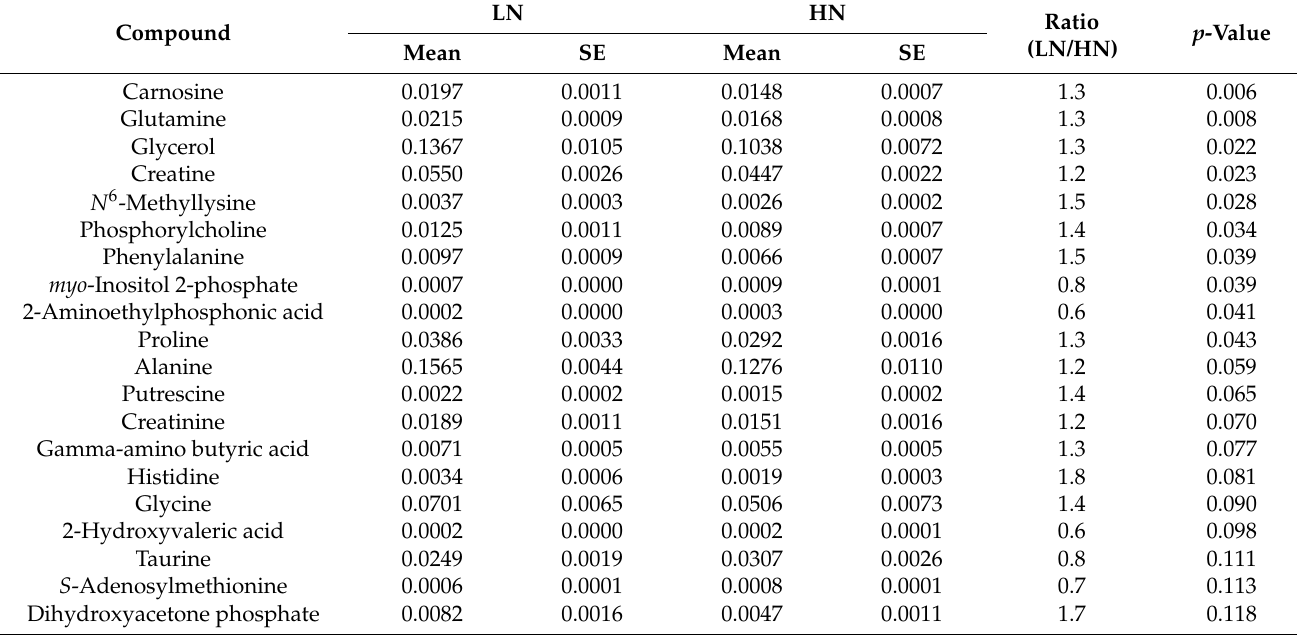
* Values in table are relative content levels (arbitrary unit). LN and HN: Low and high nutrition treatment, respectively. Unsupervised hierarchical clustering analysis (HCA) using the top 50 significantly different metabolites between the LN and HN groups classified the fetal muscle samples into LN and HN groups. Figure 1 shows that glutamine, glycerol, phosphorylcholine, carnosine, N 6 -methyllysine, creatinine, putrescine, creatine, valine, and allantoin were abundant in the LN group, whereas 2-AEP, Ins2P, taurine, S -adenosylmethionine (SAM), acid, 2-HVA, guanosine, and NAD+ were abundant in the HN group, compared with the counterpart group. This result indicated the important contribution of these metabolites to the separation of the fetal muscles between the LN and HN groups. Thus, the fetal muscle of the LN group was characterized by the abundance of metabolites such as carnosine, glutamine, glycerol, creatine, N 6 -methyllysine, phenylalanine, and phosphorylcholine. To understand biological processes associated with differentially expressed metabo- lites between the LN and HN groups, metabolite set enrichment analysis (MSEA) was per- formed using the top 50 differentially expressed metabolites. The differentially expressed metabolites were significantly associated with the metabolic pathways of pyrimidine